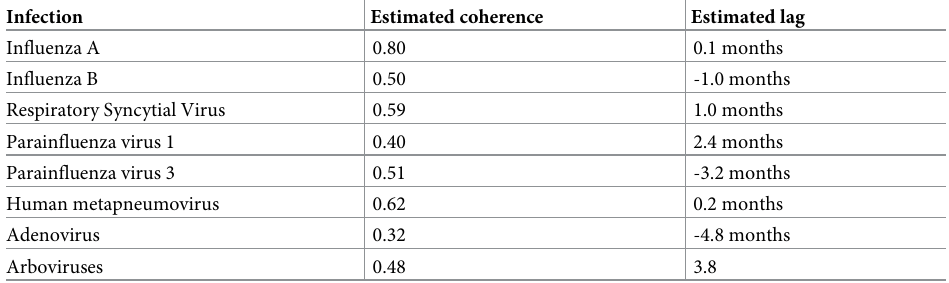
Table 3. Estimated overall mean seasonal coherence and phase difference (in months) of individual respiratory infections and arboviruses compared to all respiratory infections, Sentinel Enhanced Dengue Surveillance System (SEDSS), Southern Puerto Rico,